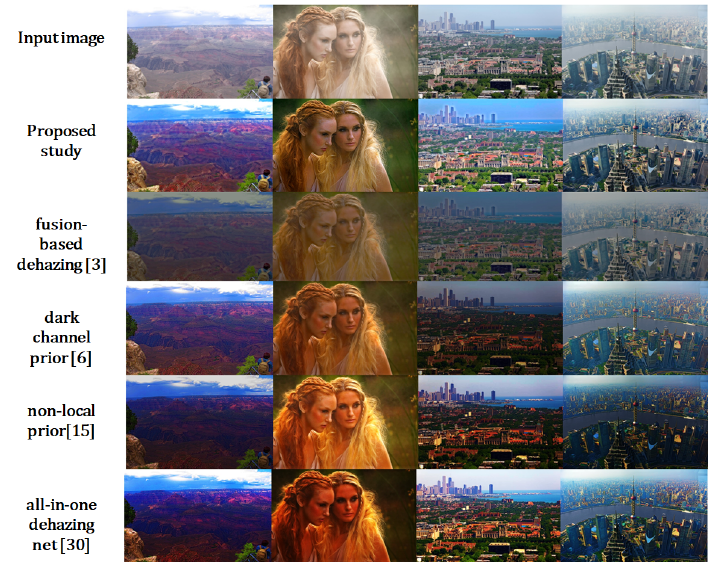
Figure 5. Visual comparison study for our network. From top to below, input image, proposed study, Reprinted from [3,6,15,30].